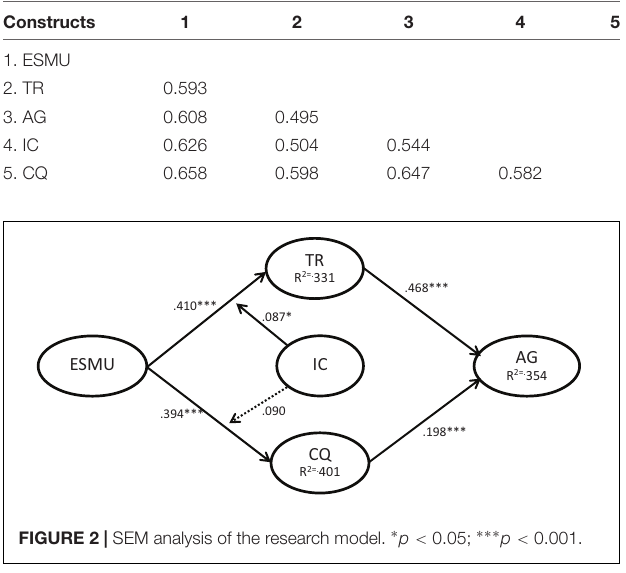
TABLE 2 | Summary of study measures, factor loadings of CFA and SEM.